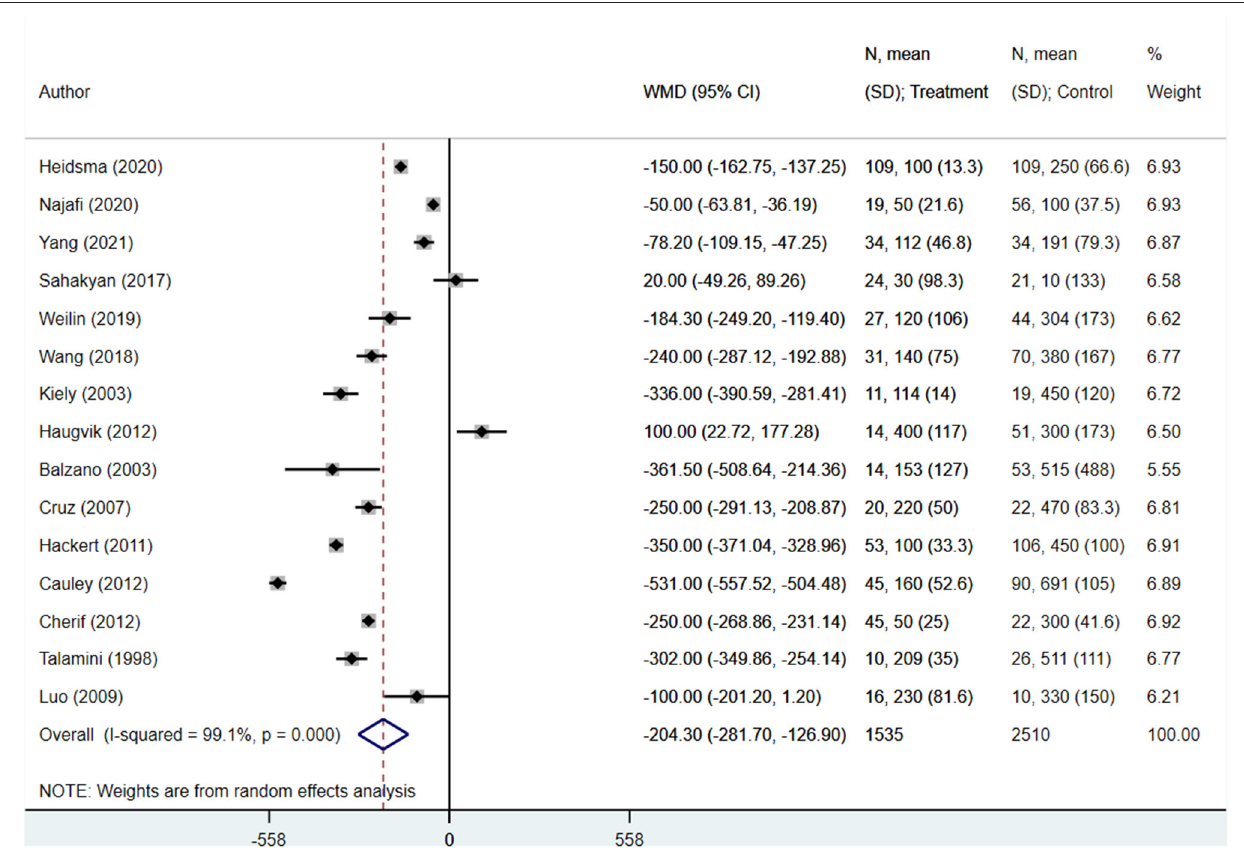
model was used (14). A p -value of < 0.05 indicated statistical significance. Egger’s test was employed to assess publication